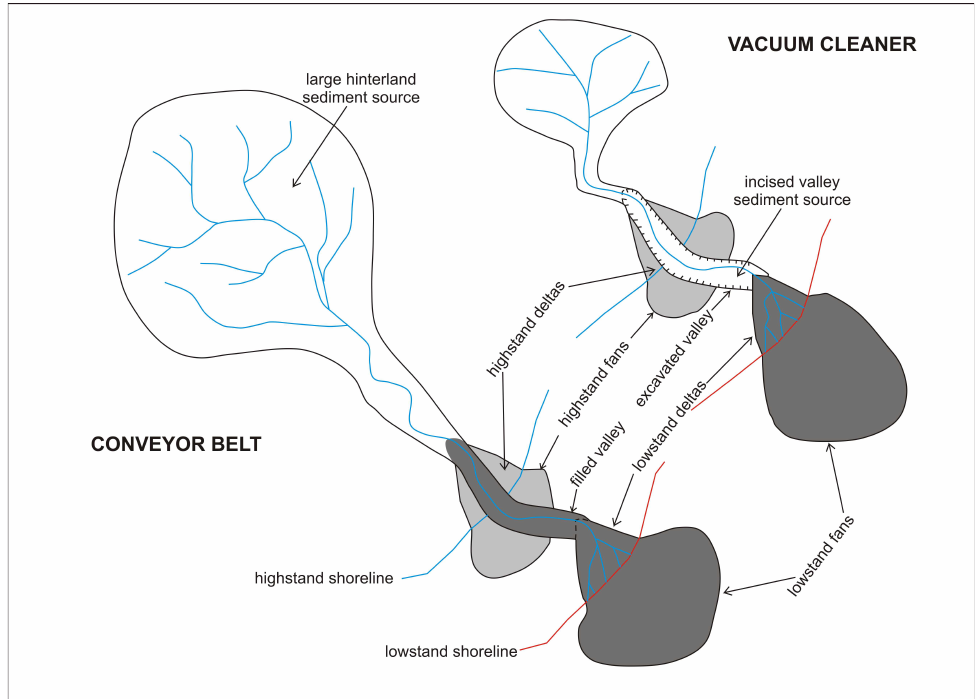
Figure 12. Vacuum cleaner vs. conveyor belt models for sediment supply for basin margins (modified from [68]). In the vacuum cleaner model, the sediments derive both from a deep valley incision and a small drainage area. In the conveyor belt model, sediments derive from a large hinterland catchment and a deep incision of the higher-order river is not